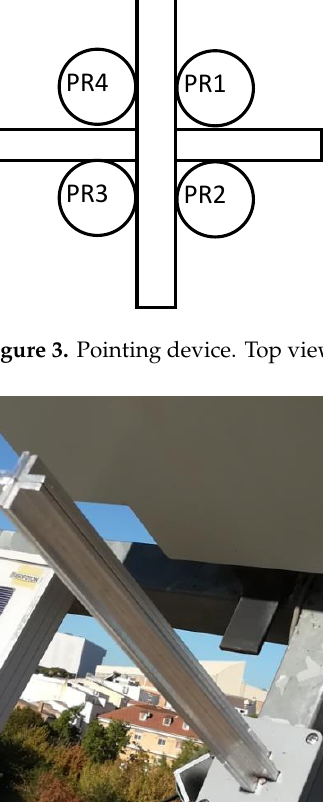
Figure 4. Pointing device.